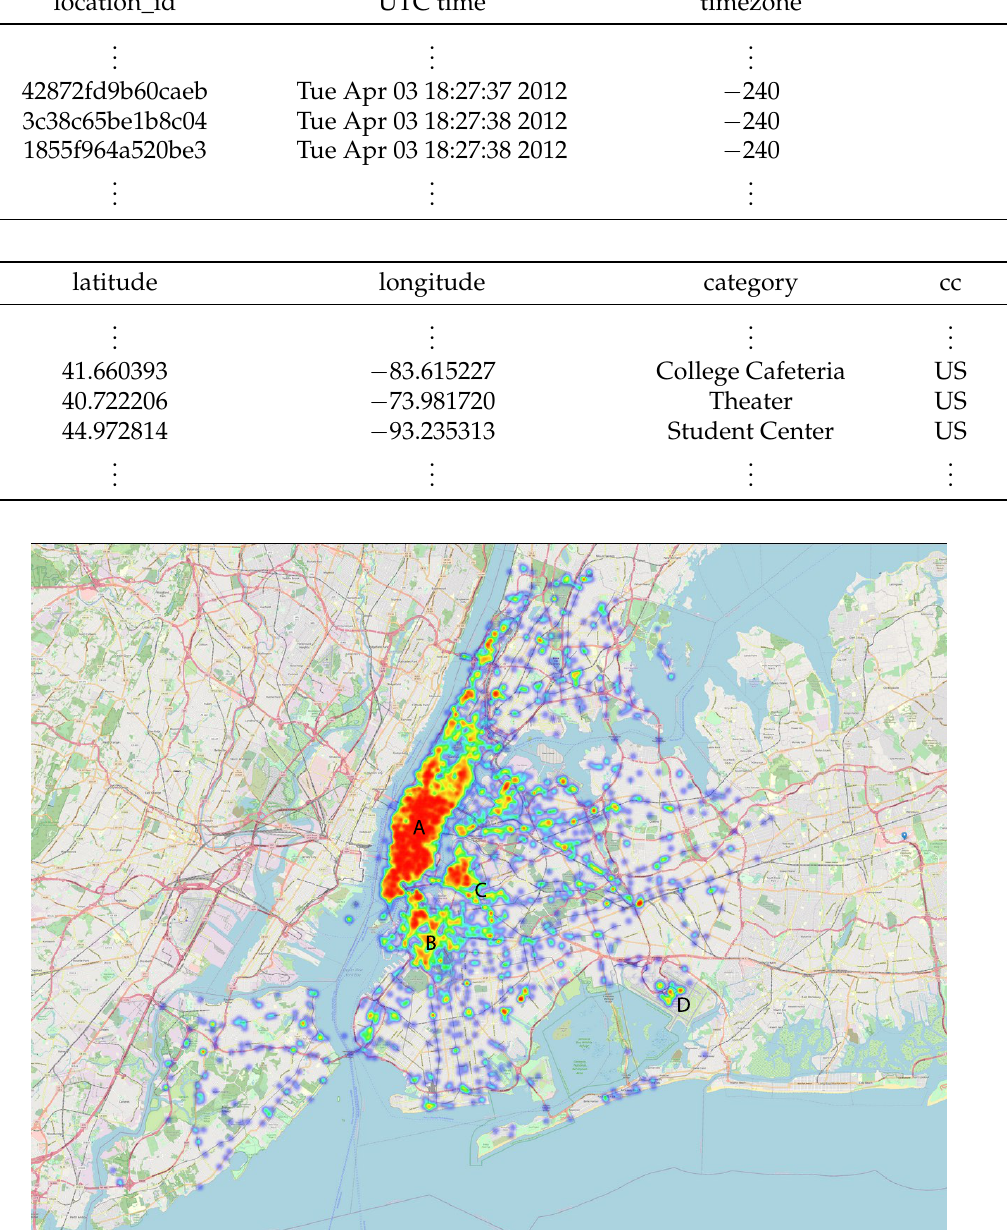
Figure 3. Heatmap of the positions of the 37,489 checkins made by 1001 individuals during three months (April 2012 to July 2012) in New York City. There is a high density of check-ins in Manhattan (A) and its surroundings (upper part of Brooklyn (B) and Queens (C)). The high concentration of check-ins in these areas can be explained because Manhattan is the most densely populated borough and the touristic centre of New York City, containing for example Times Square, Central Park, the Empire State Building, the Statue of Liberty, and Wall Street. As one may expect, another area of dense checkins is the JFK airport